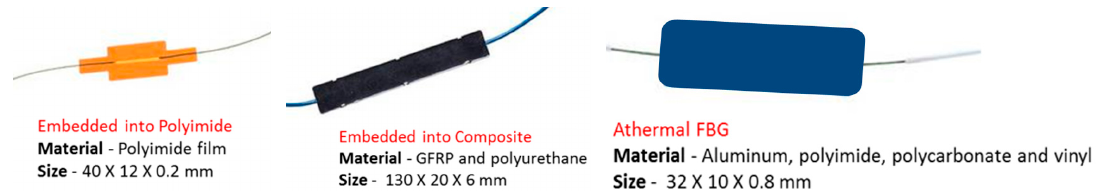
Figure 2. FBG sensors with various protection schemes.